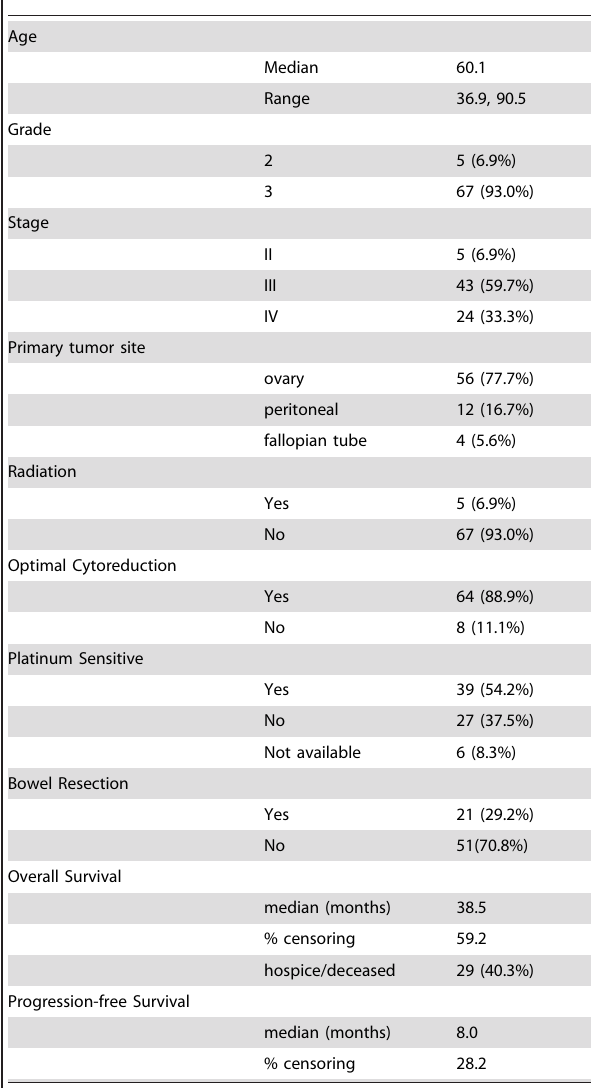
Table 1. Patient